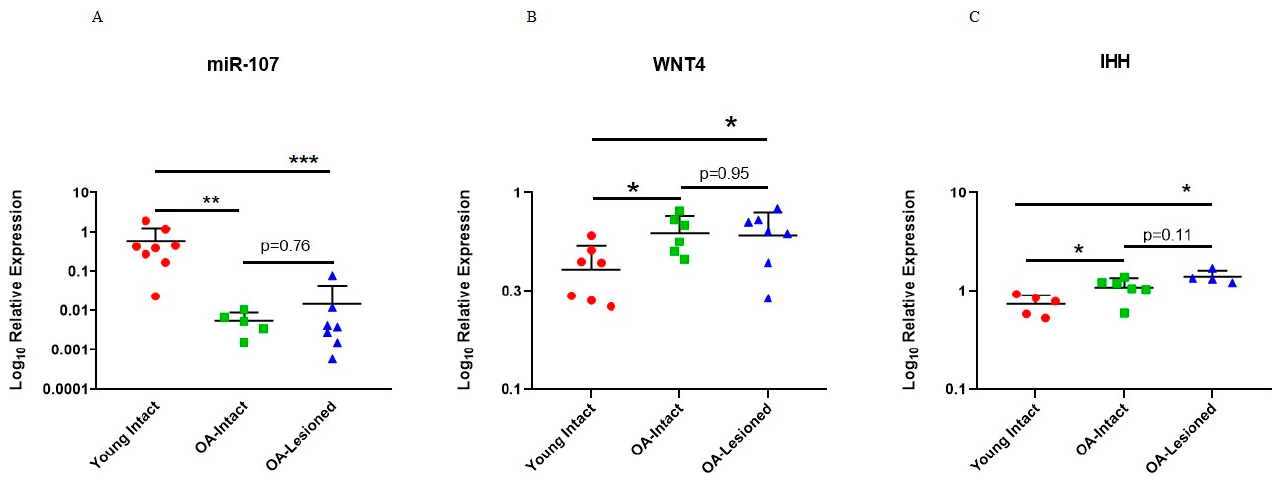
Figure 8. Expression of miR-107, WNT4 and IHH in the independent cohort of young intact and old OA intact and lesioned cartilage samples. Expression of ( A ) miR-107, ( B ) WNT4 and ( C ) IHH in young intact cartilage from ACL donors and old OA intact and lesioned cartilage is shown. Expression of miR-107 from Figure 4 is shown here again for direct comparison ( n = 5–8 donors). Y axis represents log-transformed expression relative to SNORD68 for miR-107, and relative to RPL3 for WNT4 and IHH . Statistical analysis was undertaken using a Mann–Whitney test in GraphPad Prism (Version 8.0.1). Data are represented as mean + SD. p values < 0.05 were considered significant. *: p < 0.05, **: p < 0.01, ***: p < 0.001.